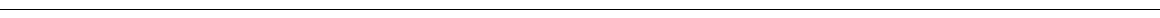
Fig. 4 IPMK and SF1 depletion suppresses PH domain accumulation and IPMK is required for ATR recruitment. a – d Western blots showing effective knock- down or knock-out with or without rescue of selected phosphoinositide kinases: PIP5K1A (siRNA), PIP5K1B (shRNA), PIK3CB (CRISPR-Cas9) and IPMK (siRNA) together with e – h the quanti fi ed accumulation magnitude of Btk-PH and PLC δ -PH after background subtraction in designated protein depleted backgrounds ( n ≥ 15 for all cases). In panel d&h, the cells were rescued with either siRNA-resistant and fl ag-tagged wild type human IPMK (siRes2-3xFlag- hIPMK-WT) or its kinase dead mutant (siRes2-3xFlag-hIPMK-D144N). Numbers labeled next to the blots indicated the molecular weight of the ladder. i Western blot showing the effective depletion and rescue of SF1 by shRNA and an shRNA-resistant Myc-DDK-tagged mouse SF1 construct (shResA-mSF1- WT-Myc-DDK). The overpression of SF1 rescue gave two separate bands, likely with and without the Myc-DDK tag. j The quanti fi ed accumulation magnitude of Btk-PH and PLC δ -PH with background subtraction in SF1 depleted and rescued conditions. k Schematic depicting the SF1-PIP 2 complex as a substrate of IPMK but not classical PI3K while both kinases phosphorylate PIP 2 in vitro. l Confocal montage of transiently expressed SF1-EGFP upon laser microirradiation. m , n ATR and γ H2AX immuno fl uorescence micrographs of U2OS nucleus upon laser microirradiation over time for control and IPMK- depleted conditions, respectively. o Normalized quanti fi cation comparing the magnitude of recruitment of ATR ( n = 20), ATM ( n = 13), DNA-PKcs ( n = 14) and γ H2AX ( n = 47) within ROIs in control and IPMK-depleted conditions. Please refer to Supplementary Fig. 4 for the representative images of ATM and DNA-PKcs staining. p Transient depletion of IPMK in U2OS cells and the q transient depletion of SF1 in MEF cells both demonstrated a suppressed phosphorylation of Chk1 upon global UV irradiation. Data are representative of three independent experiments. in all panels. Dashed circles indicate the ROI for laser microirradiation. Error bars represent mean ± s.e.m in all panels. Student ’ s t -test, ** p < 0.01; *** p < 0.001. n.s. represents not signi fi cant. Scale bars are 10 μ m for all